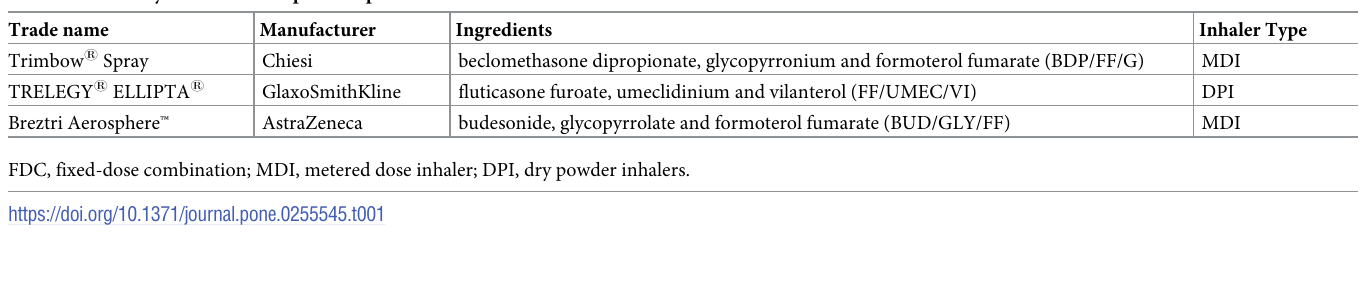
Table 1. Summary of marketed triple therapies in